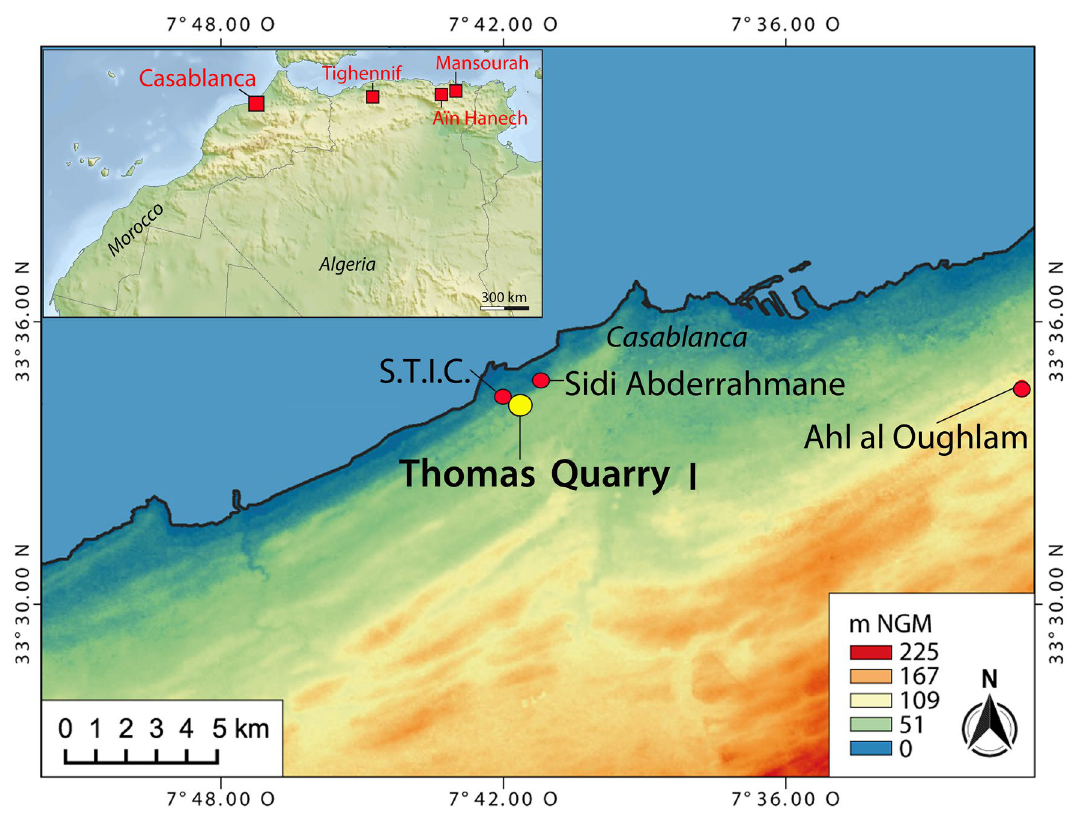
Figure 1. Location of Thomas Quarry I and all the archaeological sites cited in the text. North-Africa map: modified by R. Gallotti after NASA/JPL/NIMA, public domain, via Wikimedia Commons. Casablanca map: modified by M. Rué and R. Gallotti after NASA/SRTM, 1 arc second global elevation data, created using the free and open source software QGIS v3.18.2 (http:// www. qgis.